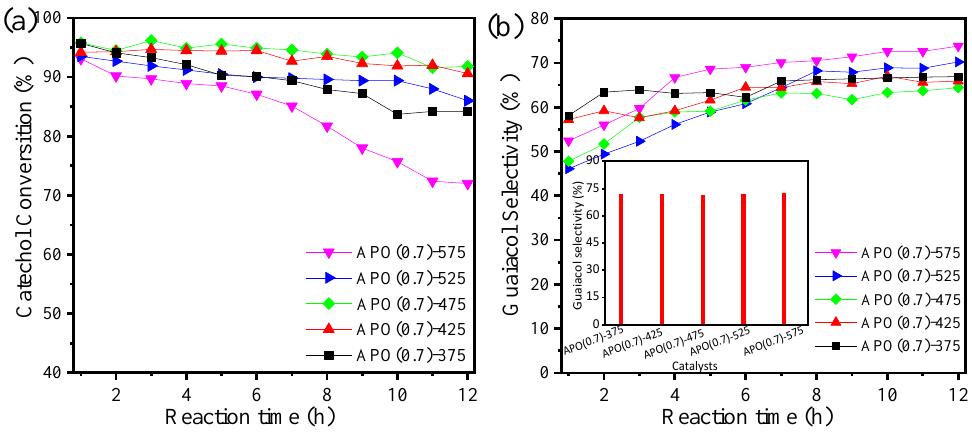
Figure 6. Effect of reaction time on ( a ) catechol conversion and ( b ) guaiacol selectivity over the APO catalysts with different calcination temperatures; the inset in ( b ) is the guaiacol selectivity at ~30% conversion of catechol. Reaction condition: 3 g APO catalyst, molar ratio of catechol to DMC = 1: 6, 300 ° C, LHSV = 0.4 h − 1 . Table 2. O -methylation of catechol to guaiacol over our proposed APO(0.7)-475 catalysts and re- cently documented catalysts.